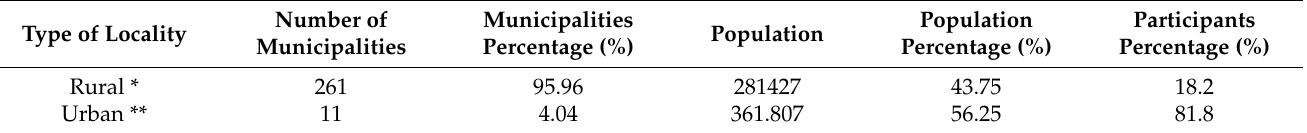
Table 1. Representation of municipalities and population of Navarre. * Rural: population, <10,000; ** urban: population, >10,000 [17]. Source: own elaboration based on data collected from the Statistics Institute of Navarre (NASTAT).